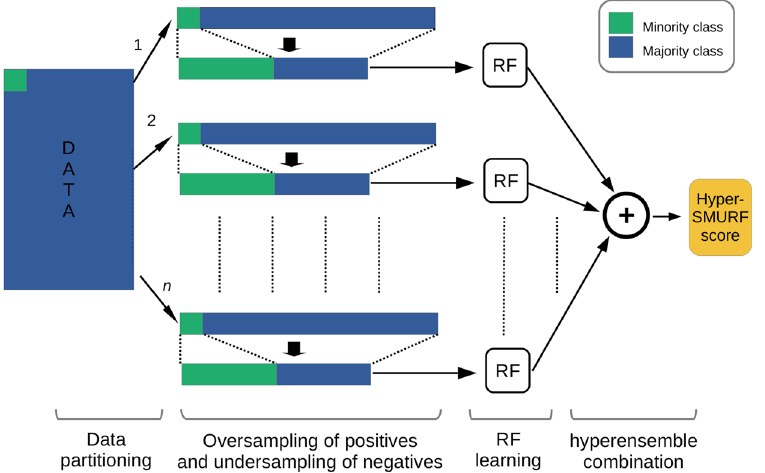
Figure 1. A schematic representation of the hyperSMURF method. HyperSMURF divides the majority class (the negative class of probably non-deleterious variants–blue rectangles) into n partitions. For each partition, oversampling techniques are used to generate additional examples from the minority class (the positive class of deleterious variants–green rectangles), that closely resemble the distribution of the actual positive examples within the vector space of genomic attributes, to amplify the number of training examples from the minority class. At the same time a comparable number of examples is subsampled from the majority class. Then hyperSMURF trains in parallel n random forests on the resulting balanced data sets and finally combines the prediction of the n ensembles according to a hyper-ensemble (ensemble of ensembles)